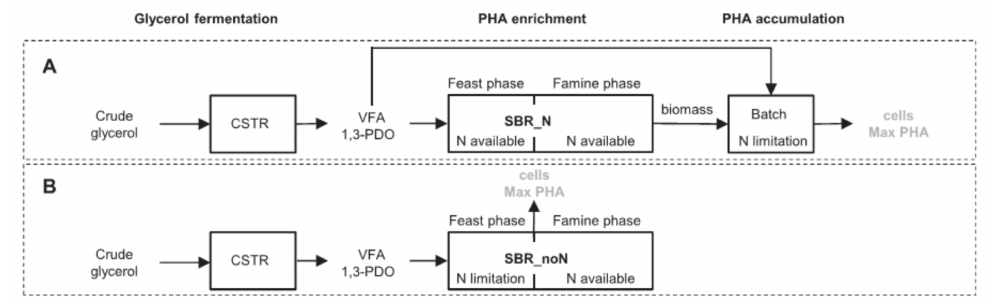
Figure 2. Summary of strategies for production of PHA from fermented crude glycerol Reproduced with permission from